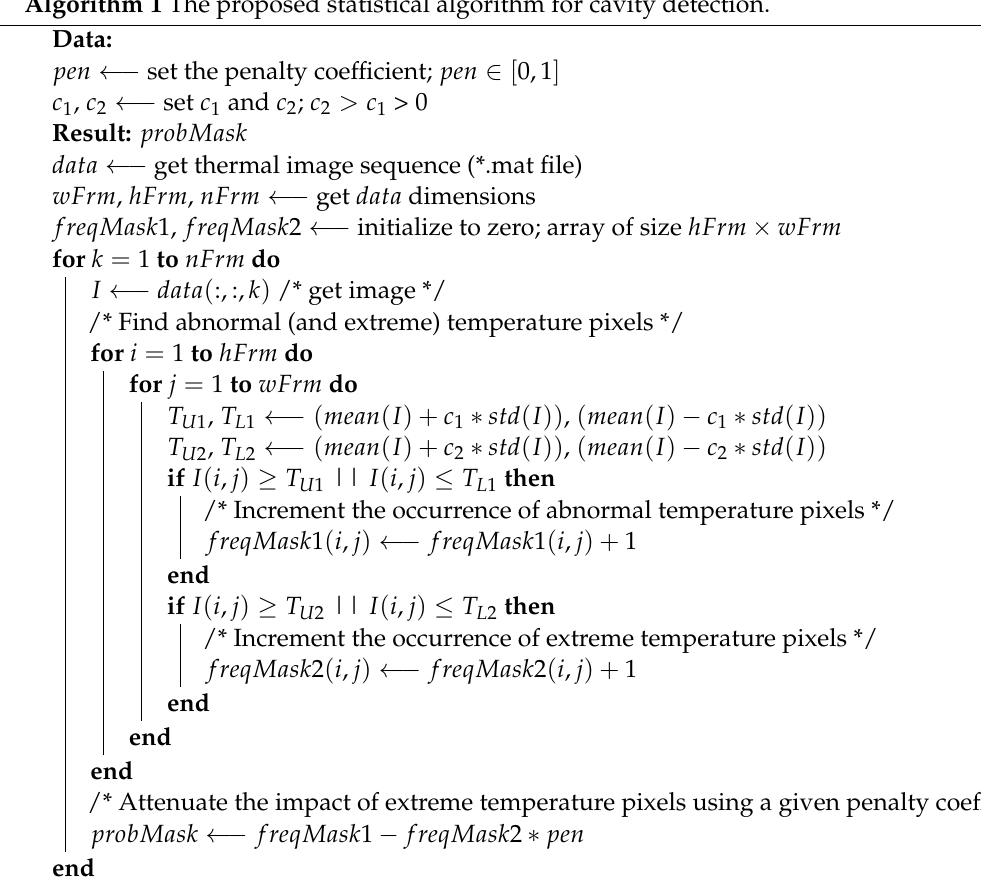
Algorithm 1 The proposed statistical algorithm for cavity